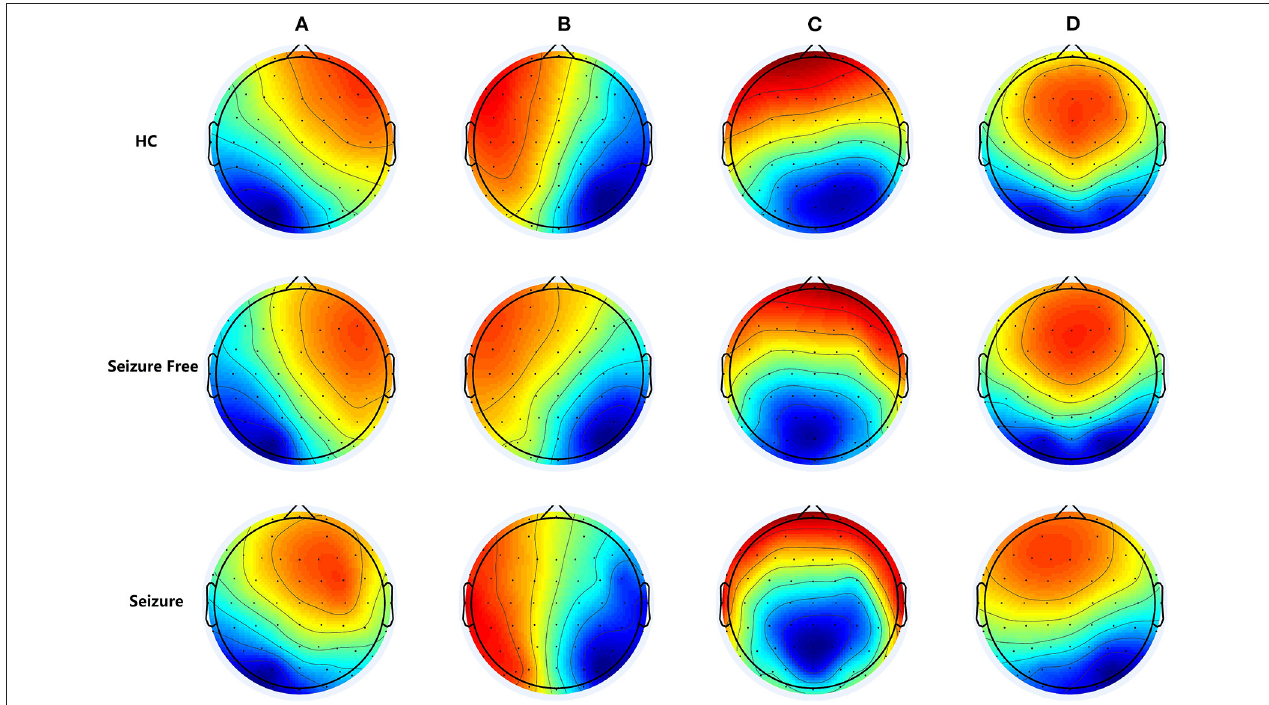
FIGURE 1 | The group-level maps of the four microstate classes (A–D) of three groups. Topographical microstate maps of three groups: Microstate class A exhibits a left-right orientation, class B a right-left orientation, class C an anterior-posterior orientation, and class D a fronto-central maximum, these four cluster maps exhibited highly similar topographies in most previously